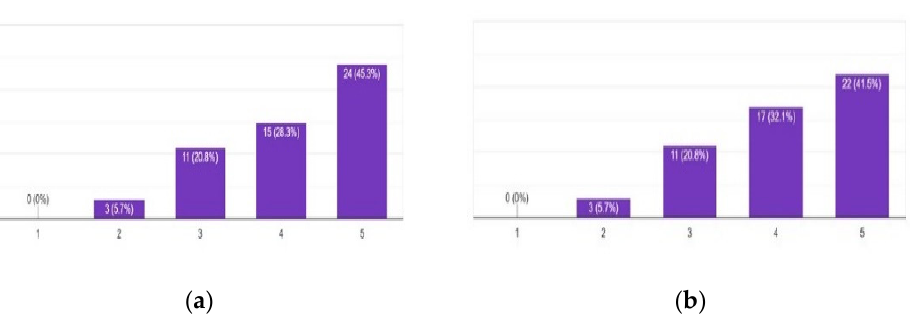
Figure 16. Participants’ opinion: ( a ) the scaled-up version is suitable for farm usage; ( b ) the scaled-up version is more attractive as an educational activity than a smaller robot.